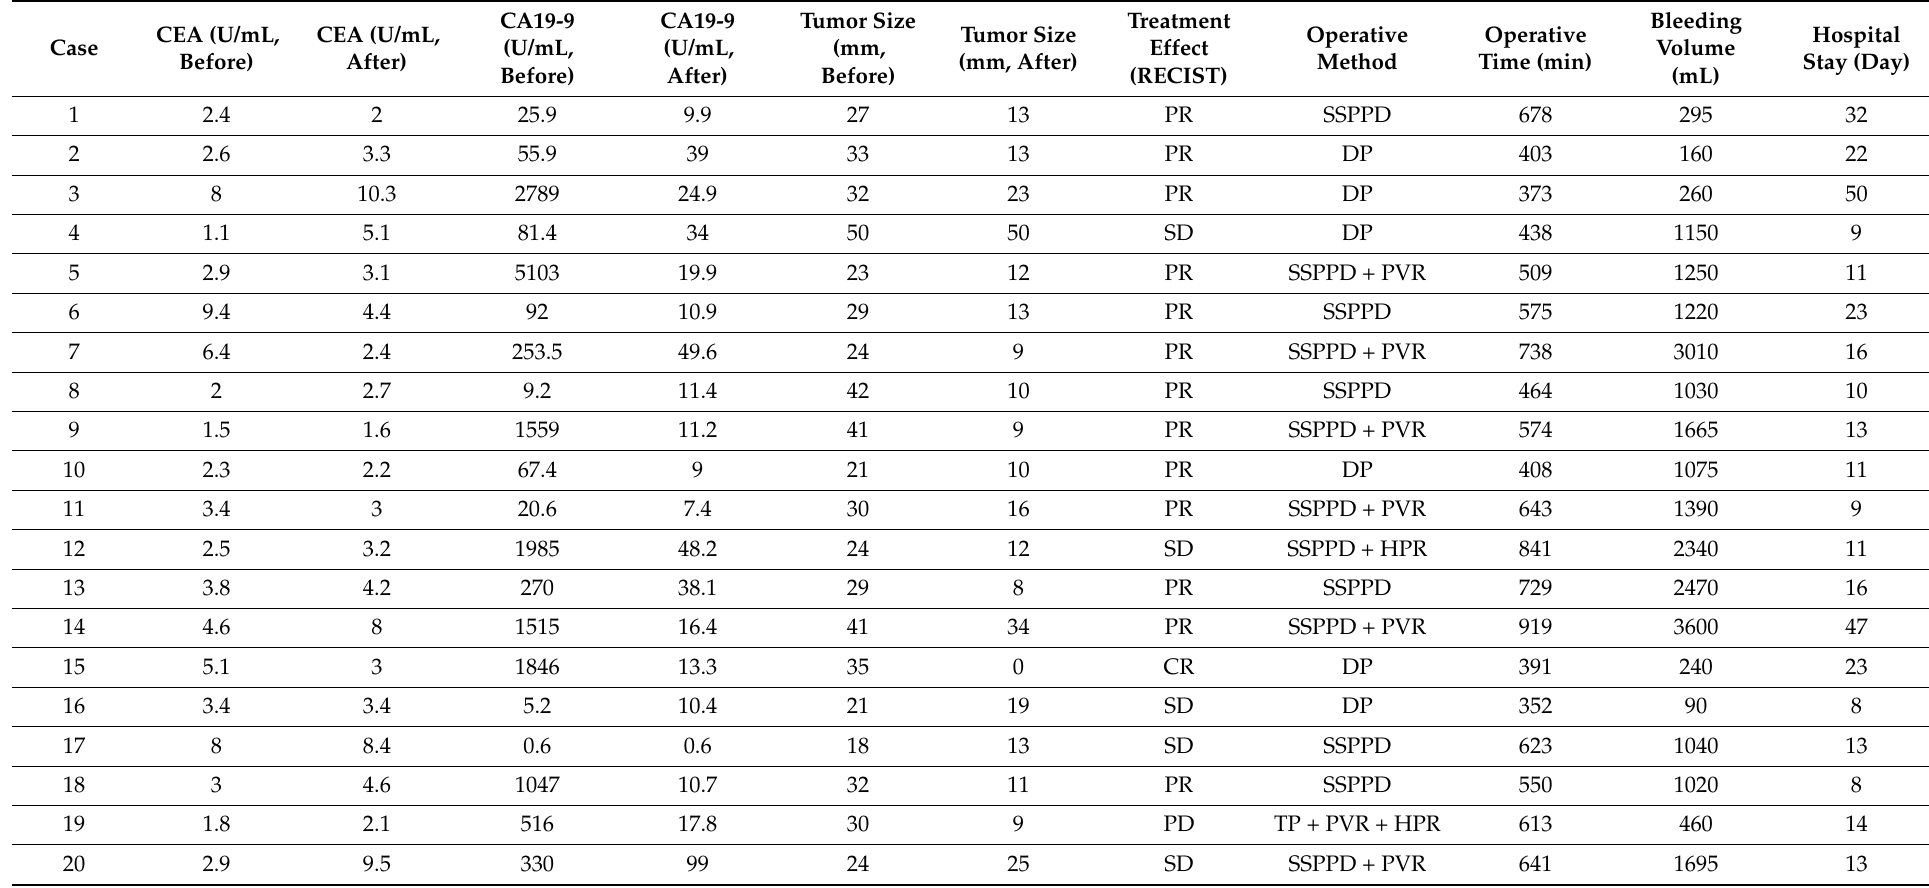
Table 2. Clinical characteristics of 20 patients who underwent conversion